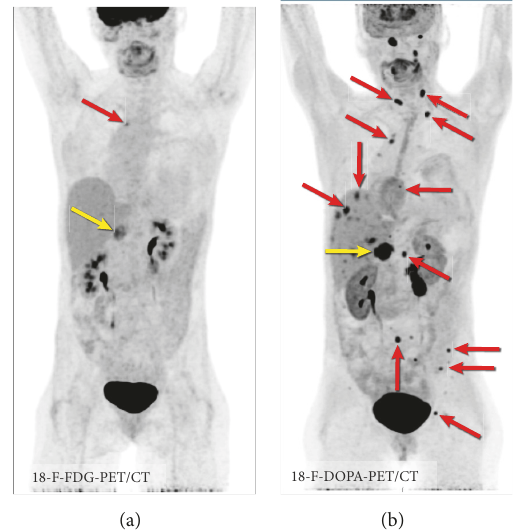
Figure 11: Imaging in MEN syndrome. 18F-FDG PET/CT (a) and 18F-FDOPA PET/CT (b) in MEN2B syndrome with metastatic pheochromocytoma (fractionated norepinephrine: 994 pg/ml, normal: 18-112 pg/ml; fractionated metanephrine: 1099 pg/ml, normal: 12- 61 pg/ml) and metastatic medullary carcinoma (calcitonin: 5575, normal: < 8 pg/ml). In this case, the primary pheochromocytoma is seen in all images (yellow arrow); however, metastatic lesions are best visualized on 18F-FDOPA PET/CT (red arrows). Imaging cannot differentiate between medullary carcinoma metastases and metastases originating from